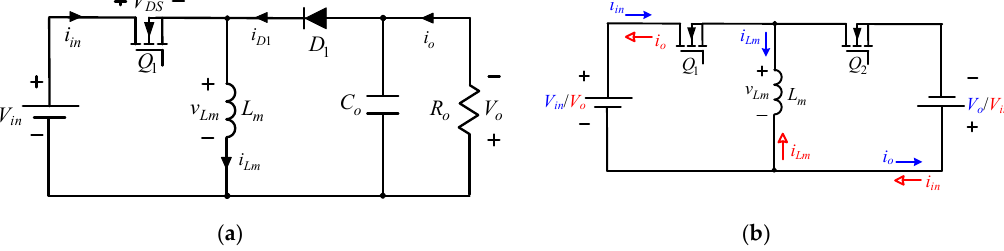
Figure 2. Development of the parallel converter leg (PCL): ( a ) Conventional buck–boost converter and ( b ) modified buck–boost converter with bidirectional energy transfer.